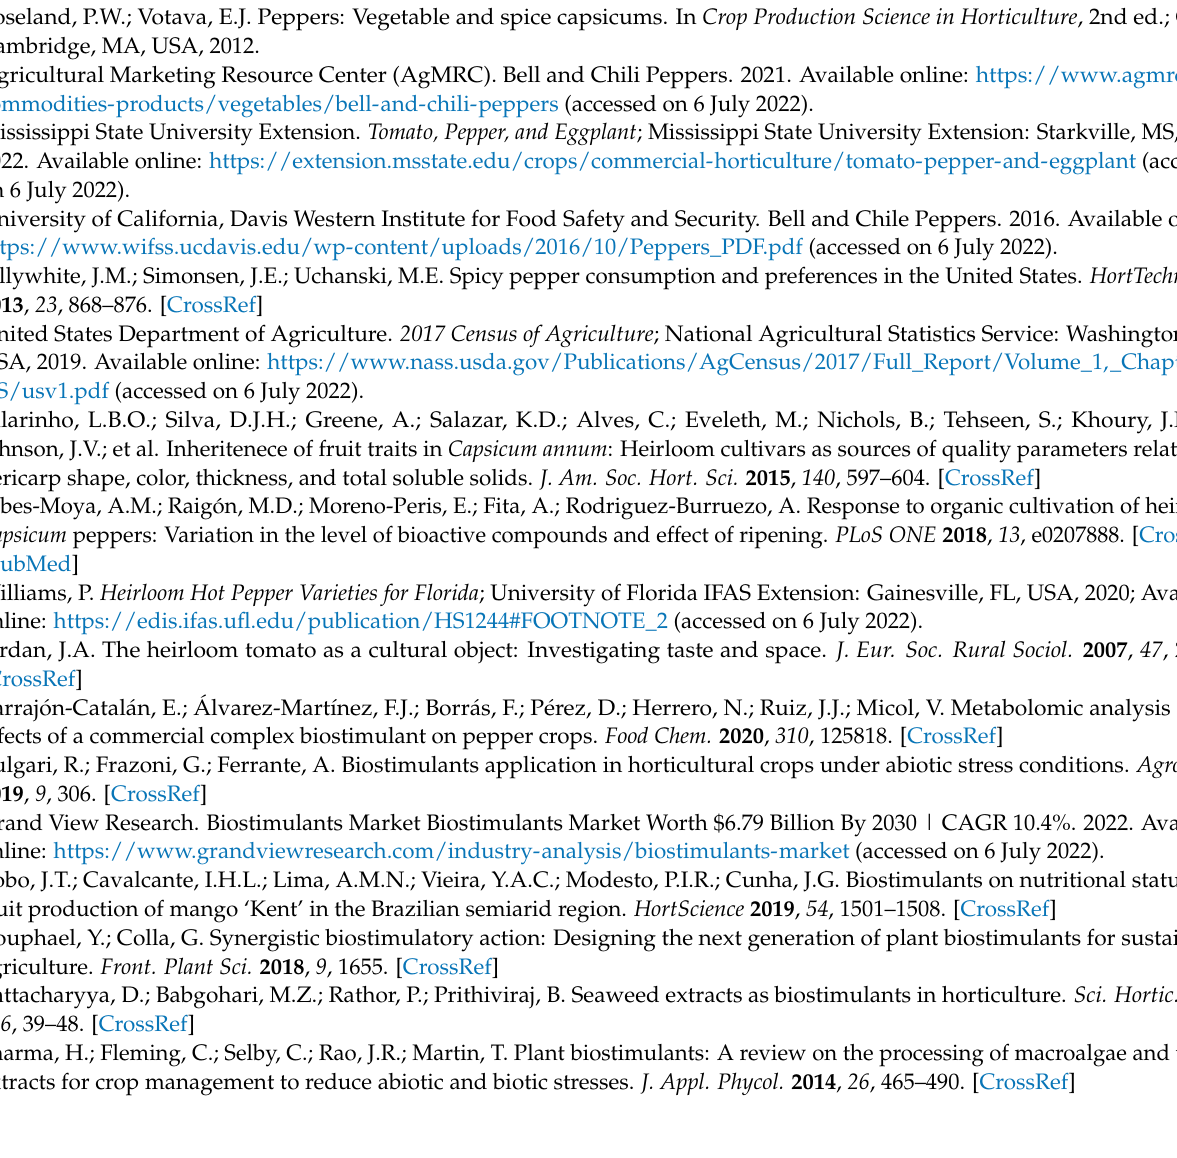
Table S2: Fruit color of chile peppers affected by the interaction between cultivar and biostimulant treatment in 2020; Table S3: Fruit color of chile peppers affected by the interaction between cultivar and biostimulant treatment in 2021; Figure S1: Daily average outdoor air temperatures within the experiment duration in 2020 (A) and 2021